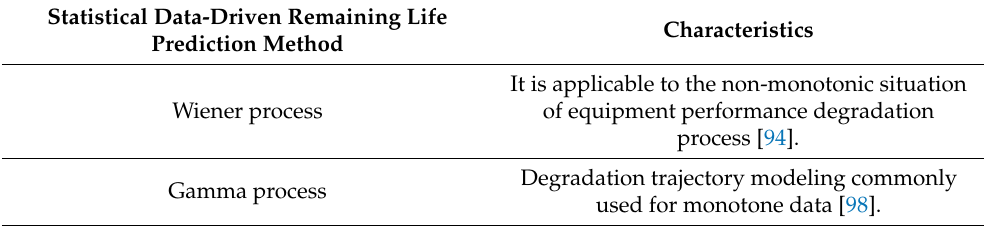
Table 7. Classification and characteristics of statistical data-driven remaining life prediction